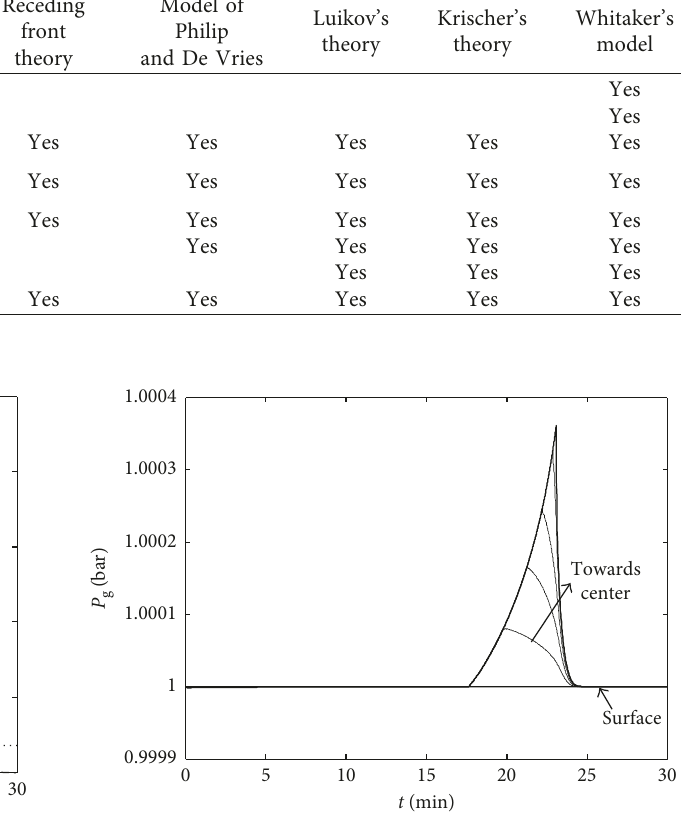
Figure 6: Drying of a sphere of light concrete: temporal evolution of pressure for approximately every 0.5mm in distance along the radial direction.